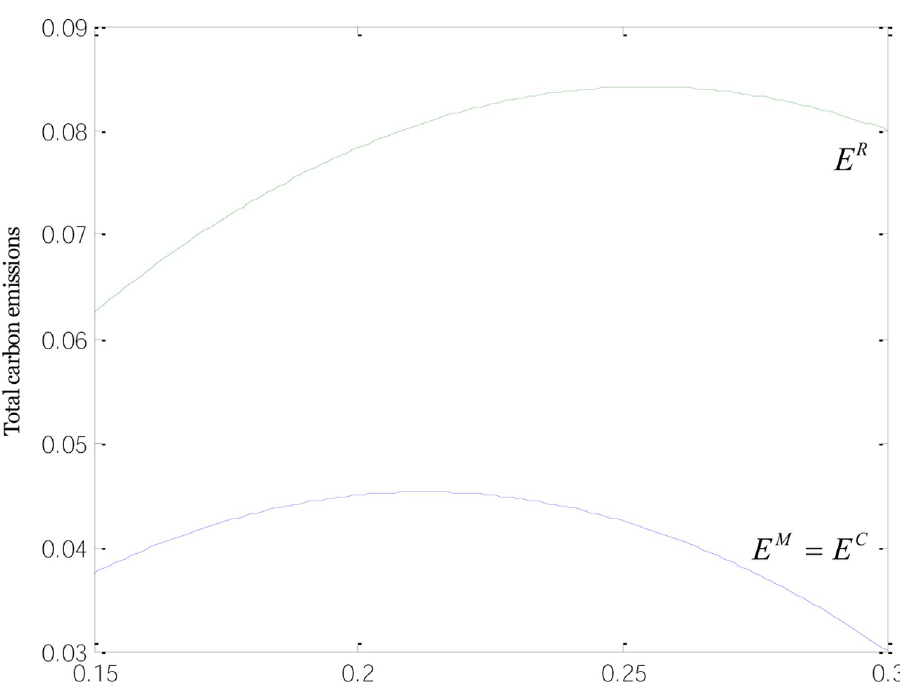
Fig 8. Relationships between total carbon emissions and low-carbon